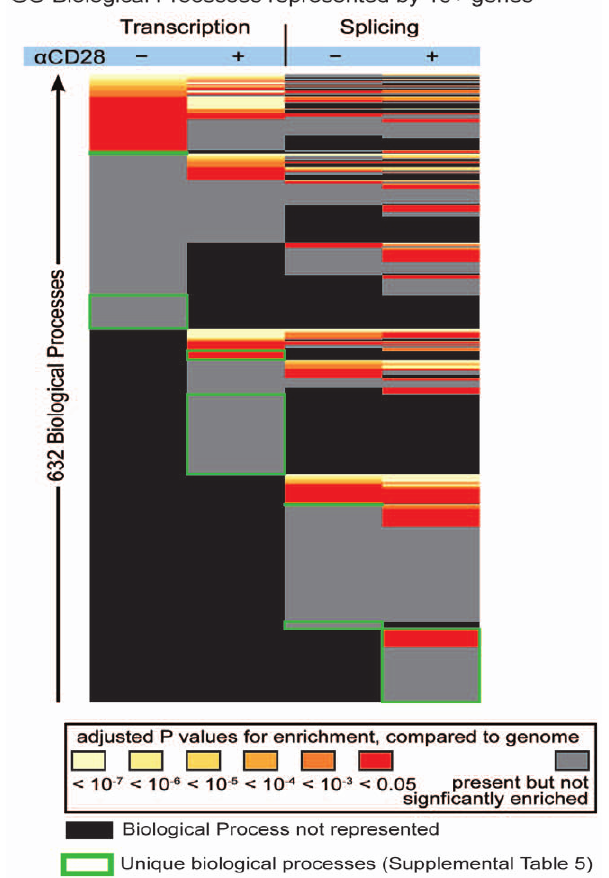
Figure 2. Functional families for genes whose transcription or splicing is affected by TCR alone or TCR/CD28. Biological processes, as defined by Gene Ontology, were counted if at least 10 genes comprising that process were present and were clustered in four groups: transcription or splicing in T cells activated through TCR alone or through TCR and CD28. The biological processes that were unique to each of the four conditions are indicated by the green boxes, and are listed in Tables S5 and S6. If biological processes were statistically enriched compared to the whole genome, color indicates adjusted p values of enrichment , 0.05 (shades of red), p . 0.05 (grey).